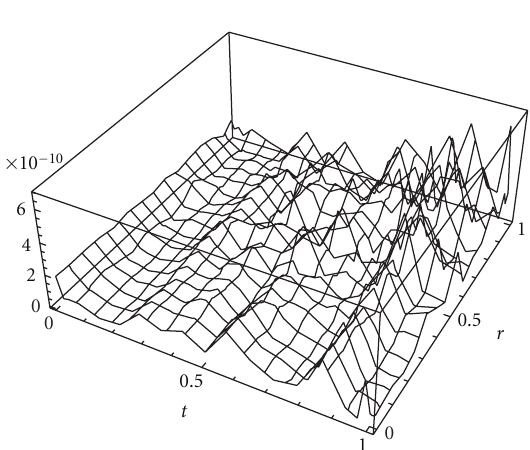
( t , r ) for (cid:2) = − 1 . 01756. 15